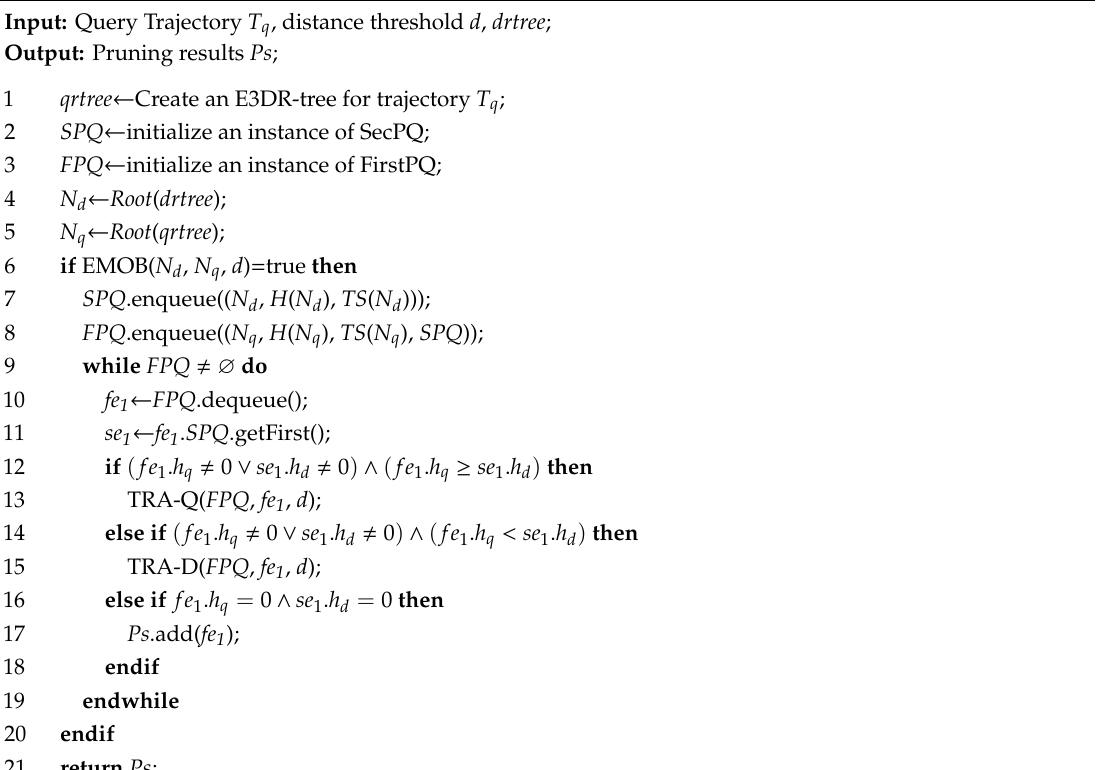
Algorithm 2. Best-First Traversal